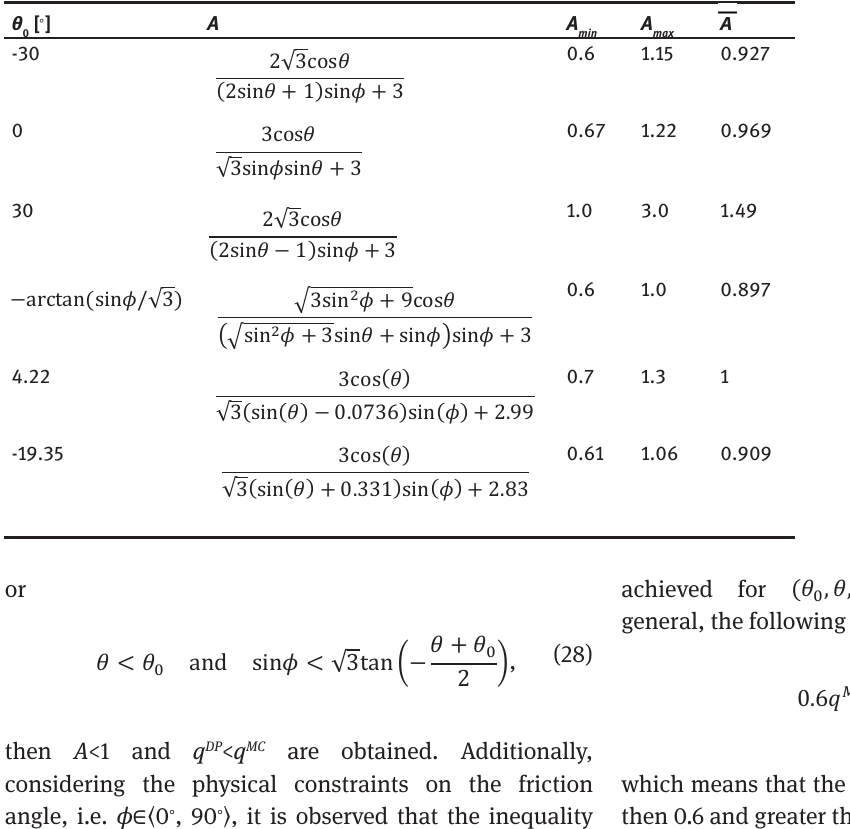
Table 1: Expressions for coefficient A and its minimum, maximum and average values for the selected values of θ